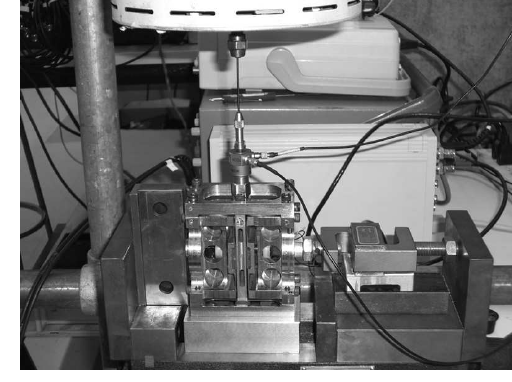
Fig. 6. Picture of the experimental set-up.